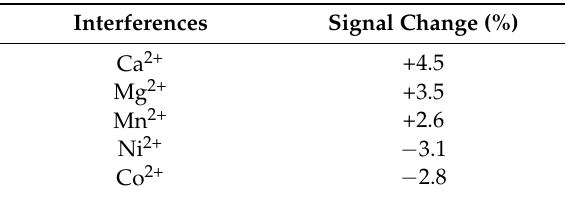
Table 2. The effect of various interferences on the peak current of Pb 2+